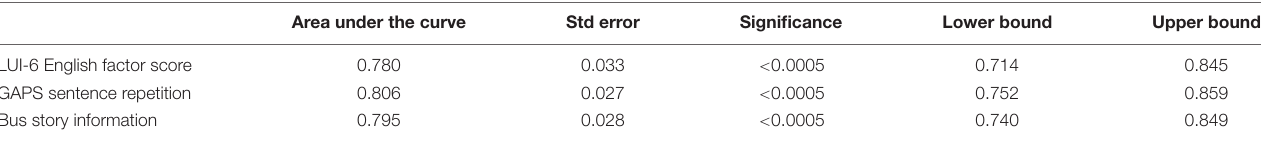
TABLE 6 | ROC analysis for LUI-6 English factor score and direct language assessments in identifying children with the greatest levels of language learning need: area under curve and 95% CI. Area under the curve